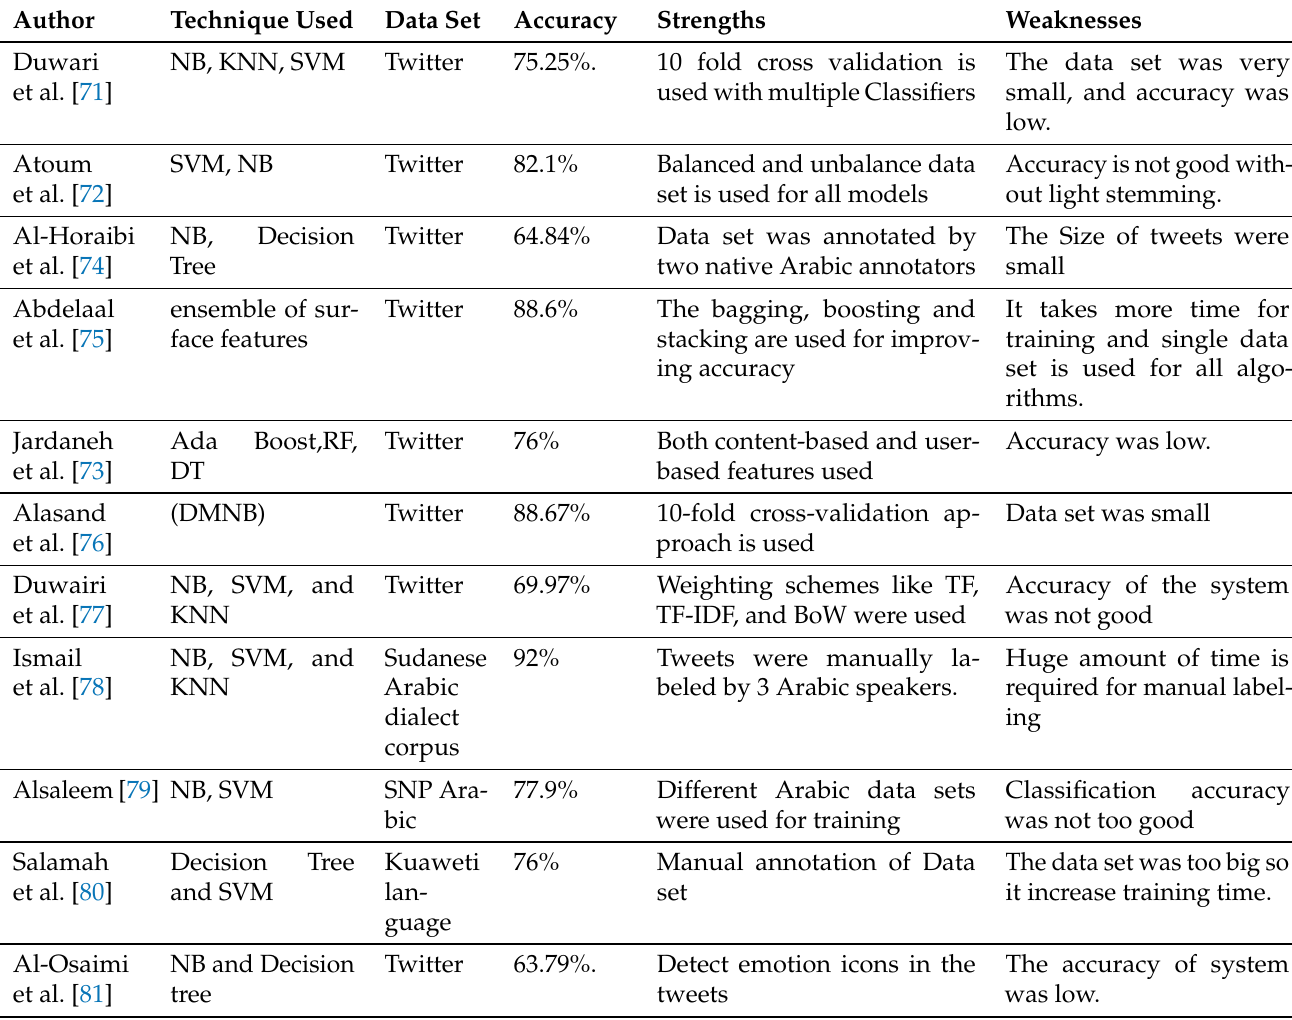
Table 2. Comparison of supervised techniques used for Arabic text